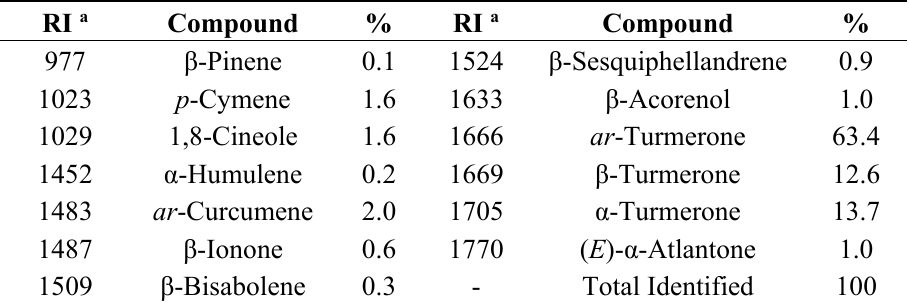
Table 1. Chemical composition of Curcuma longa leaf essential